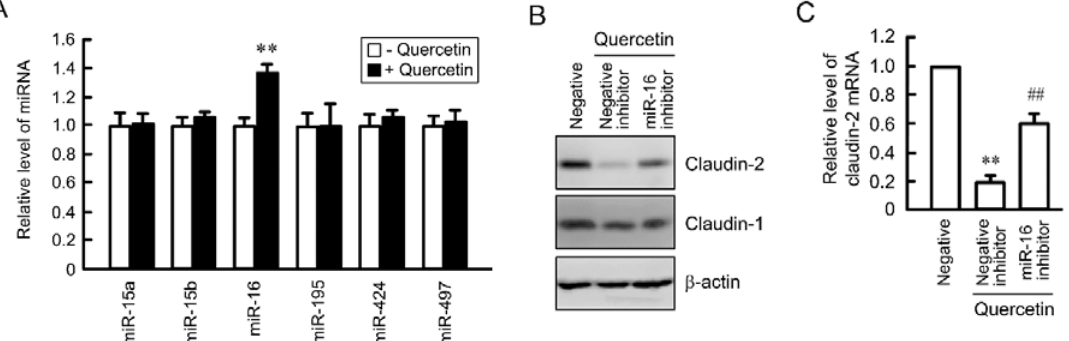
inhibitor. ( A ) A549 cells were incubated in the absence and presence of 50 μM quercetin